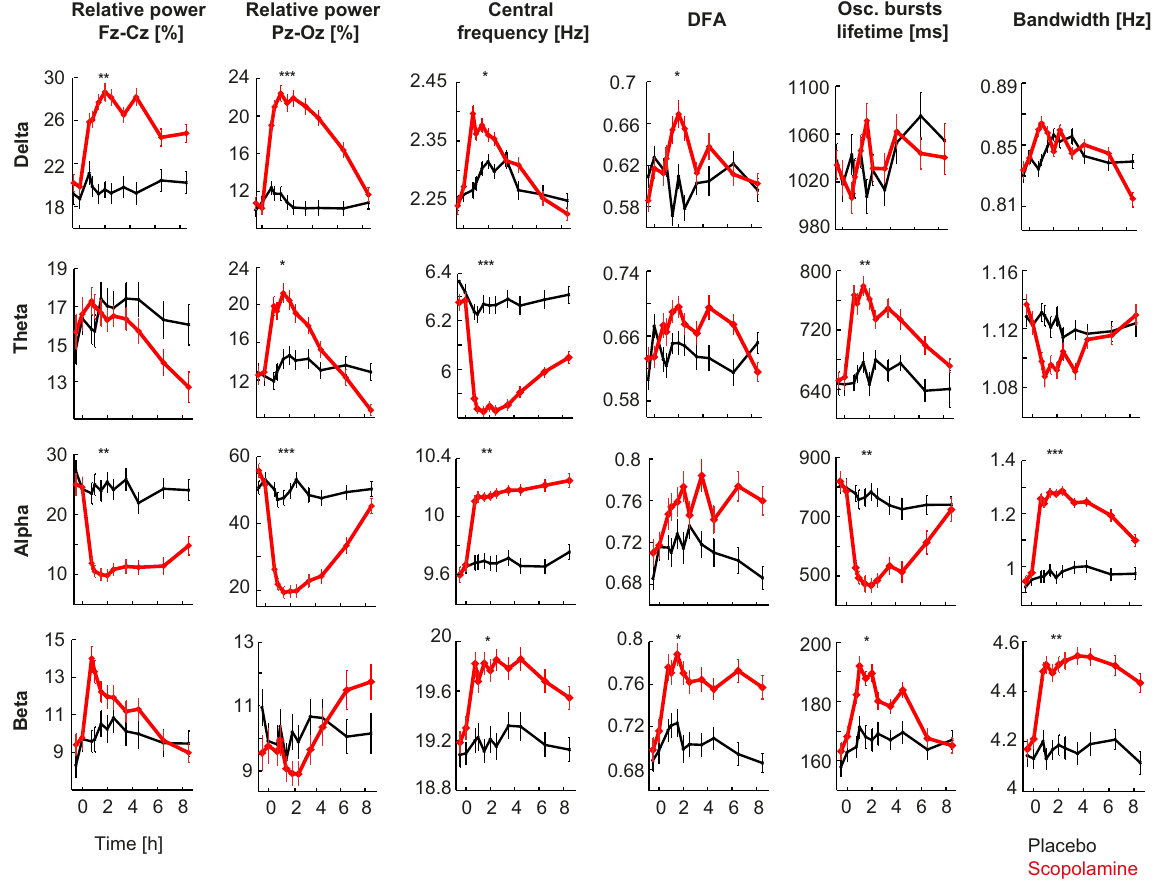
Figure 2. Scopolamine affects many characteristics of the EEG. Time dependence of different EEG biomarkers (columns) and frequency bands (rows) for placebo ( black ) and scopolamine ( red ). All biomarkers are shown as averages over the 2 channels, except for relative power, for which the Fz-Cz and Pz-Oz channels are shown separately, because the effects in the delta and beta bands were opposite for the two derivatives. Sixteen biomarkers were significantly affected by scopolamine, with the peak effect occurring 1.5 h after administration. The values plotted are group means and standard errors of the mean computed for the within-subject design 67 . Significance levels: * denotes p < 0.05, ** p < 10 − 5 , *** p < 10 − 10 ; Bonferroni corrected for multiple